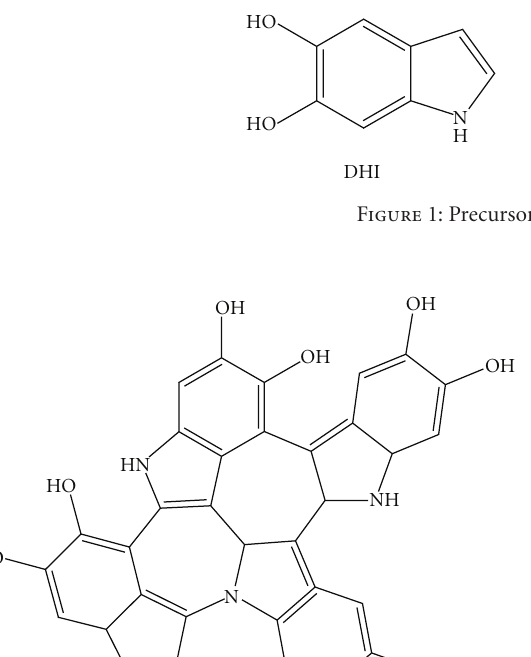
sites and to see the morphological di ff erences in these types of